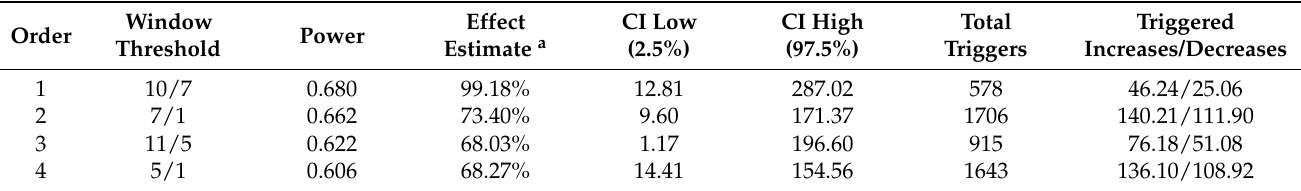
Table 3. Order of dynamic algorithm settings with respect to power estimates.